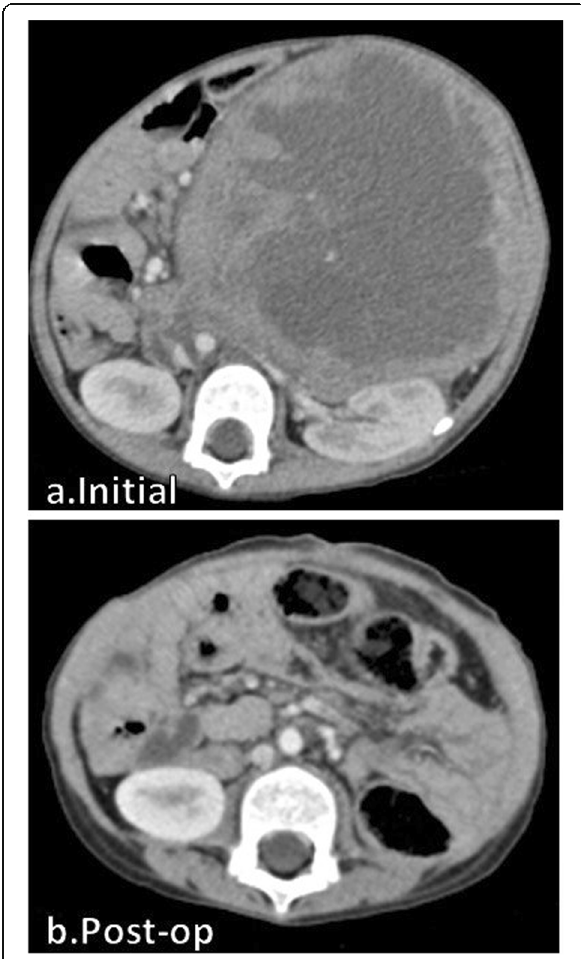
Fig. 8 A 3-year-old female. a Initial CT axial cut showing huge abdominal neuroblastoma, flattening (encasing) the left renal vein, displacing (not infiltrating) the left kidney, posteriorly. b Post- operative CT axial cut showing evidence of left nephrectomy with clear operative